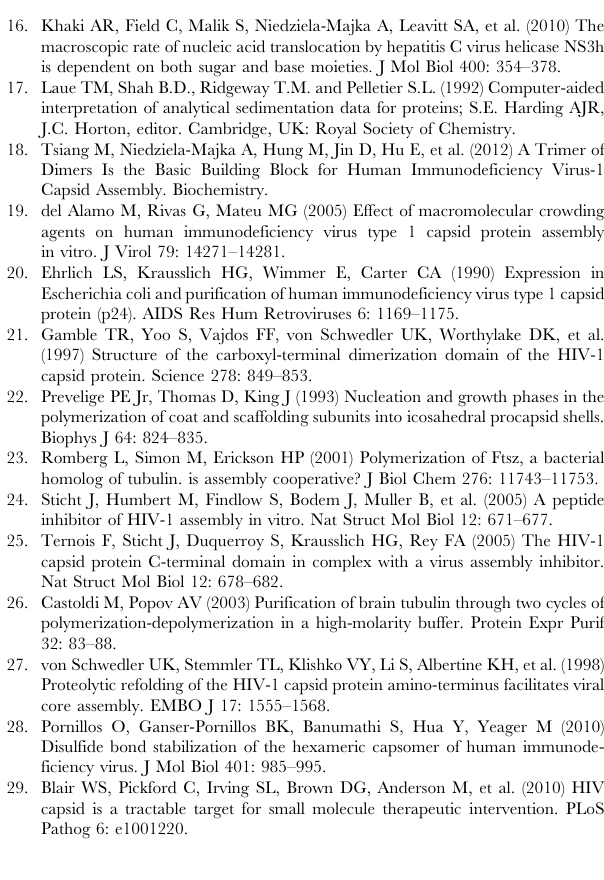
Figure S3 SDS-PAGE analysis of the final pool of CA 4Mu monomer ([A14C,E45C,W184A,M185A]CA). Lane M, SeeBluePlus2 Marker; Lane 1, Q column Load; Lane 2, Q-Flow- through. Figure S4 Mass spectrometry analysis of purified capsid proteins. All proteins were analyzed by ESI-ToF.